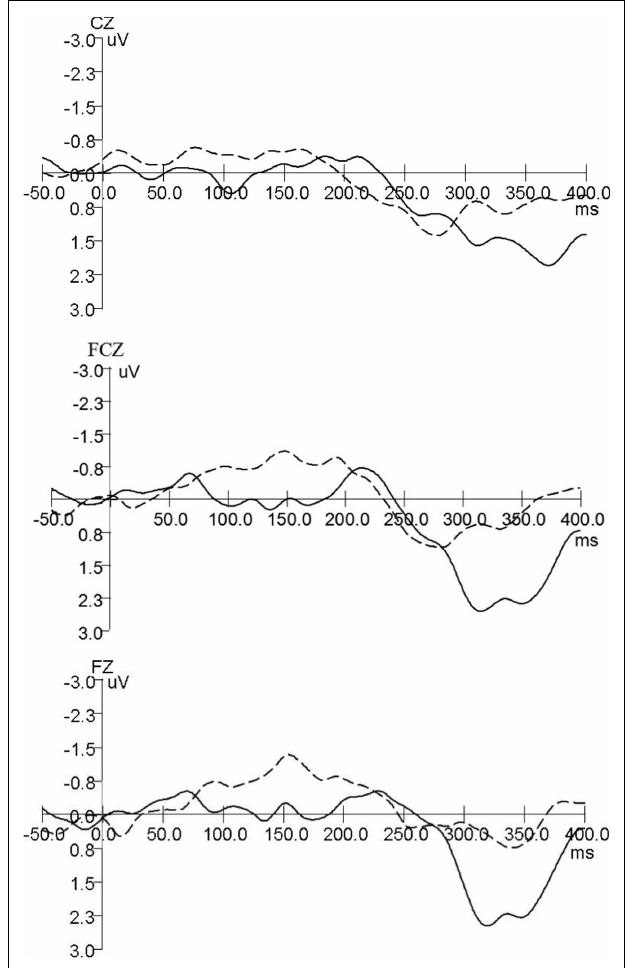
FIGURE 1 | Grand average MMN wave forms for aMCI and healthy controls . Mismatch negativity (MMN) component was identified in both groups of participants (control and aMCI). Control and aMCI adults showed differences for MMN component (— aMCI, ... healthy controls).